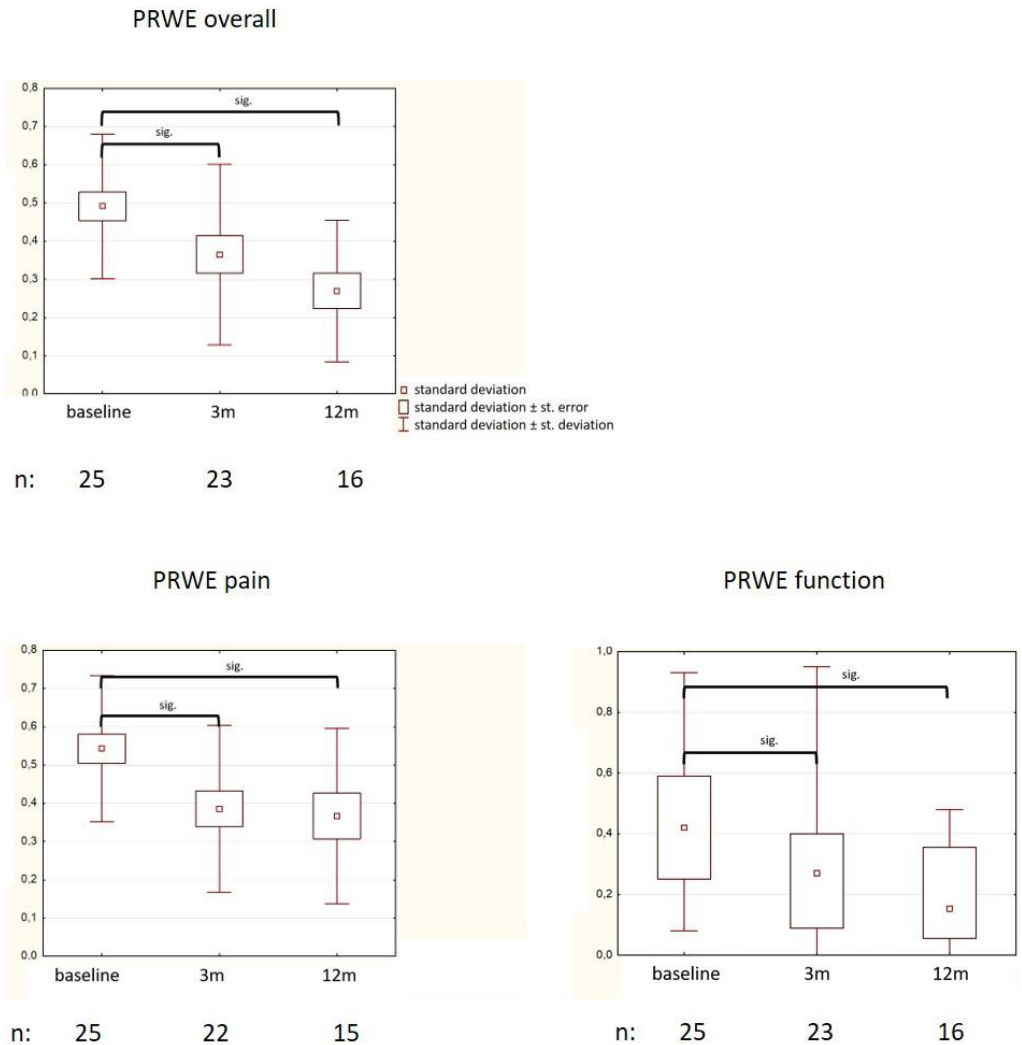
Figure 2. Changes in PRWE (patient-rated wrist evaluation) values (mean value, standard error, standard deviation are given at each time point).